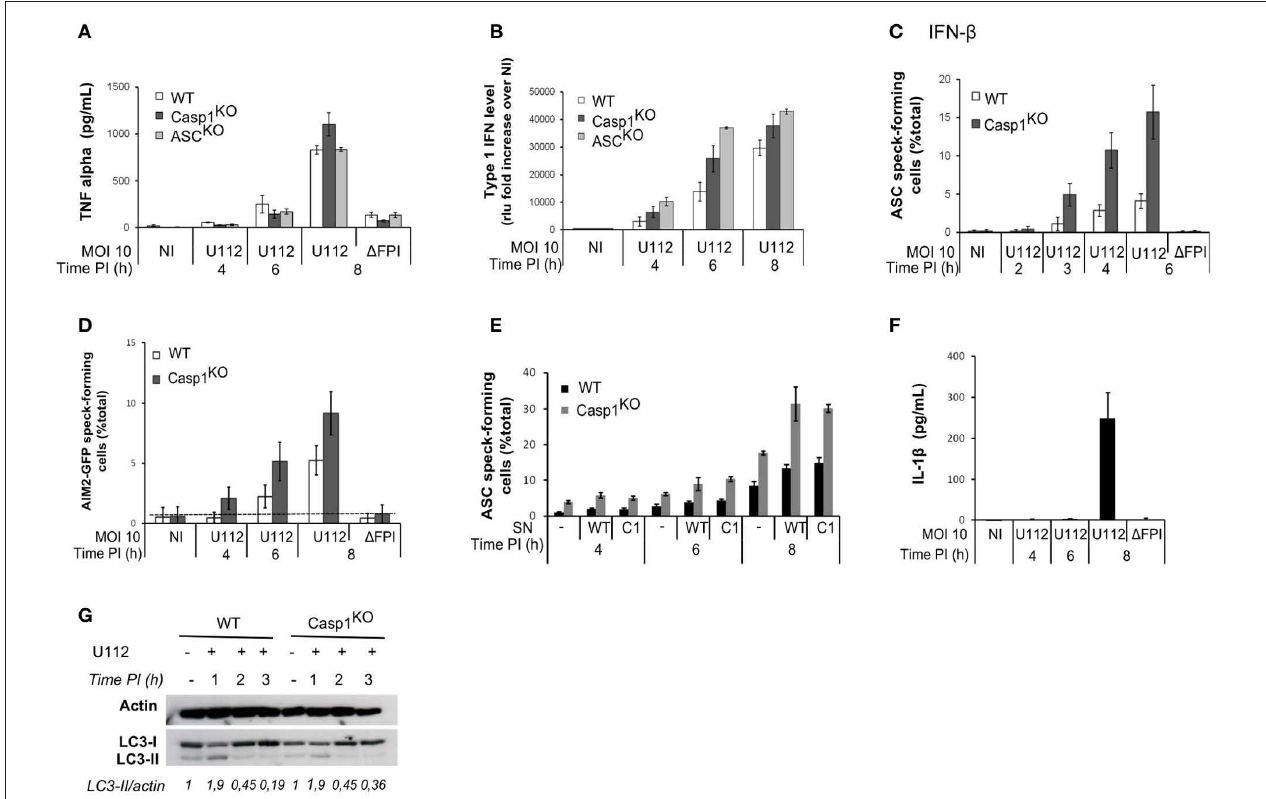
FIGURE 4 | The ASC/caspase-1-mediatednegativeregulation of AIM2 complexformationisnotduetoregulationofTNF- α ,IFN- β ,secretedfactors or autophagylevels. TNF- α (A) and type I IFN (B) levels in the supernatantof infectedmacrophageswere determinedby ELISAand a luciferase-based bioassay, respectively. (C) Macrophageswere prestimulatedwith IFN- β (100u/ml)for 3h beforeinfection.ASC speck-containingmacrophageswere scored byimmunofluorescence. (D) AIM2-GFP-transducedmacrophages were scored for AIM2-GFPspeckbyfluorescencemicroscopy. (E) ASC speck-formingcells were scoredbyimmunofluorescencein